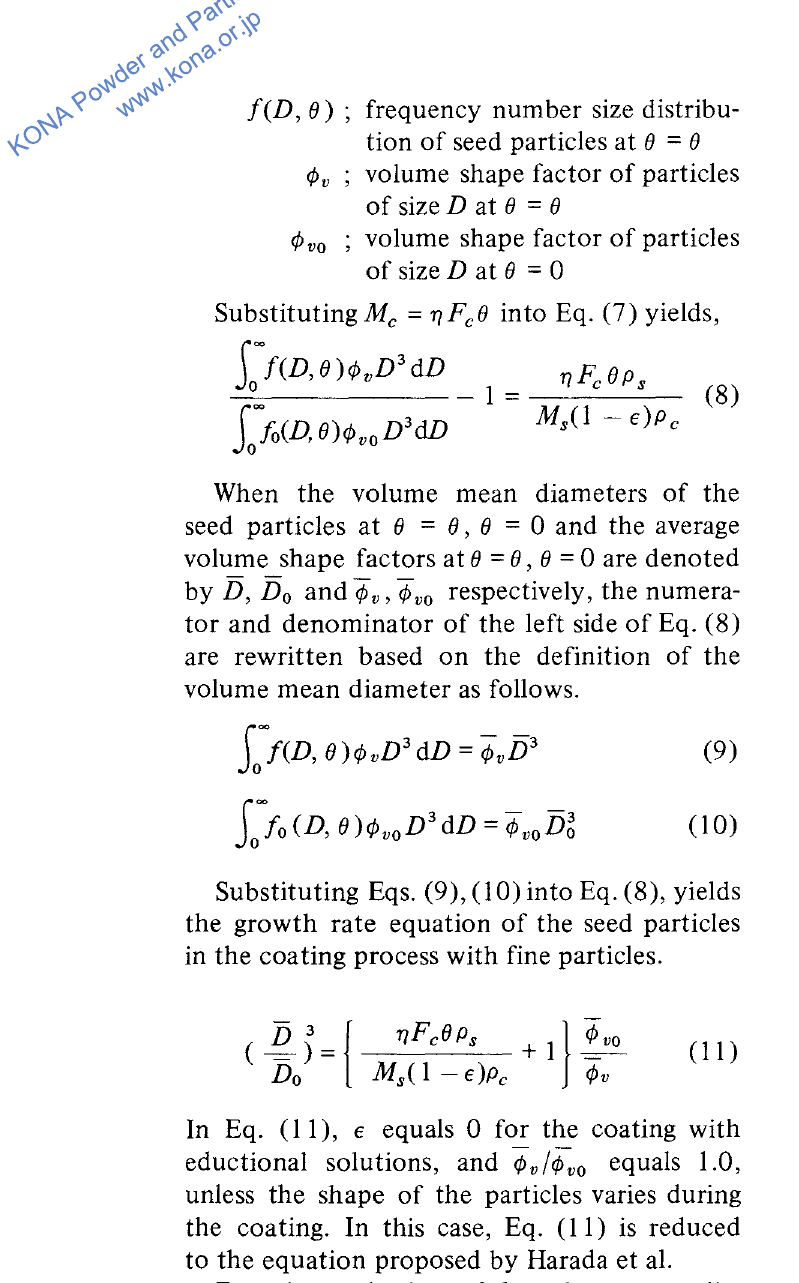
Table 4 Comparison of experimental values of volume mean diameter of coated particles with